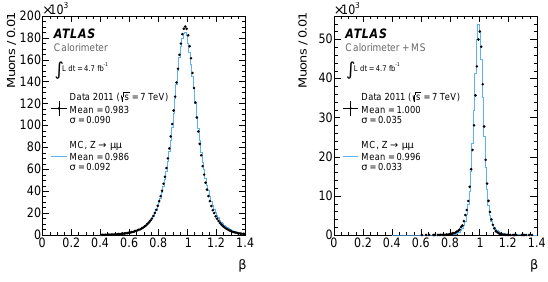
µµ decays in data →